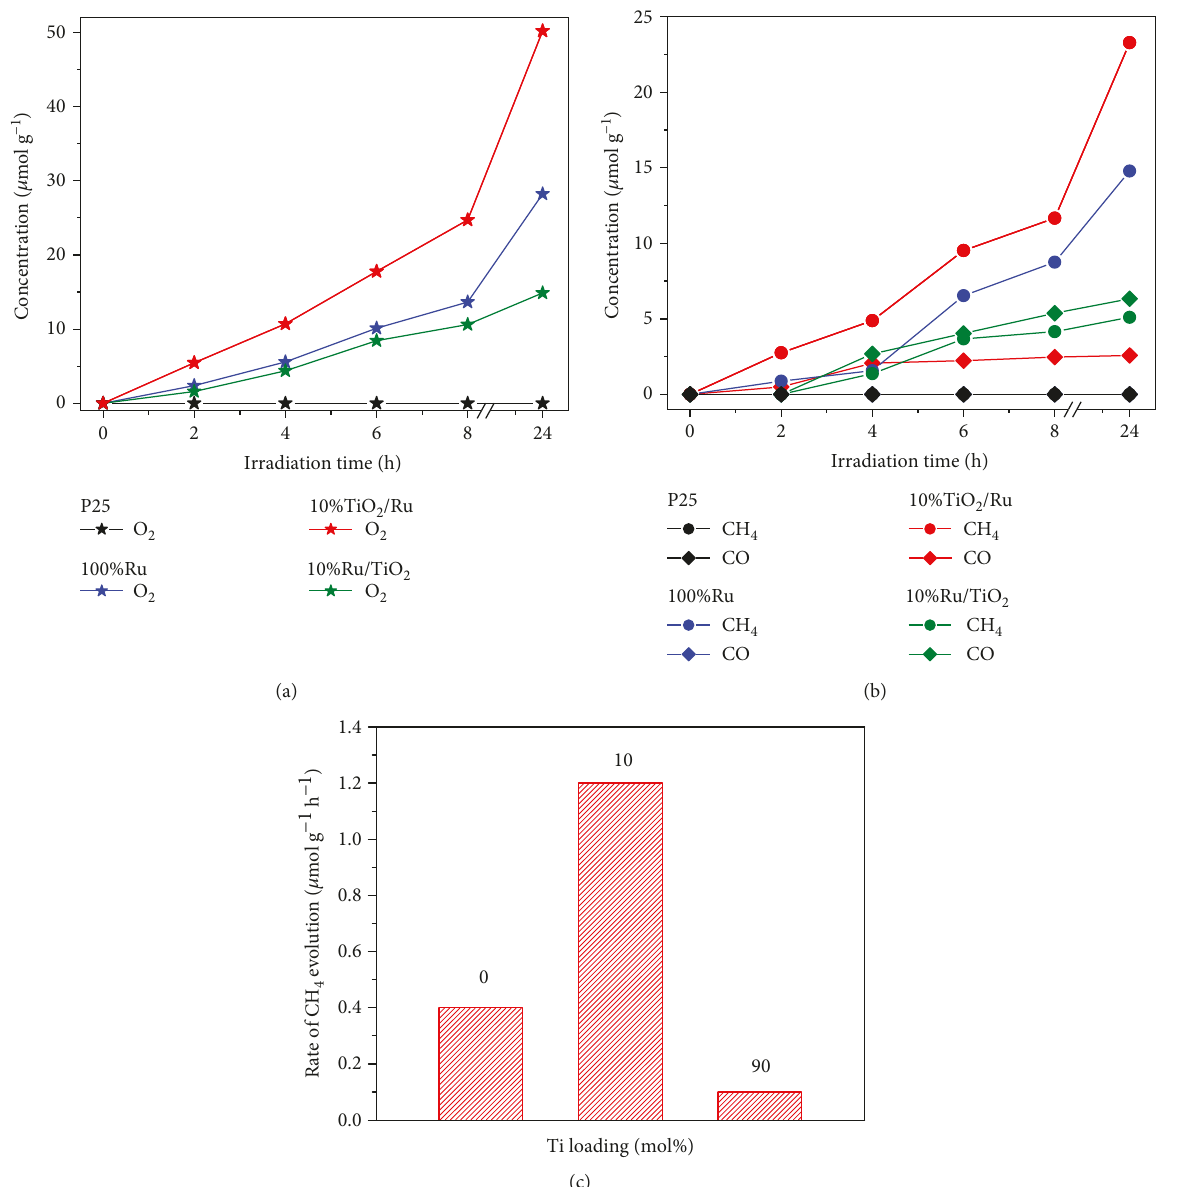
Figure 6: Evolution of (a) O over each of the Ru-containing catalysts.